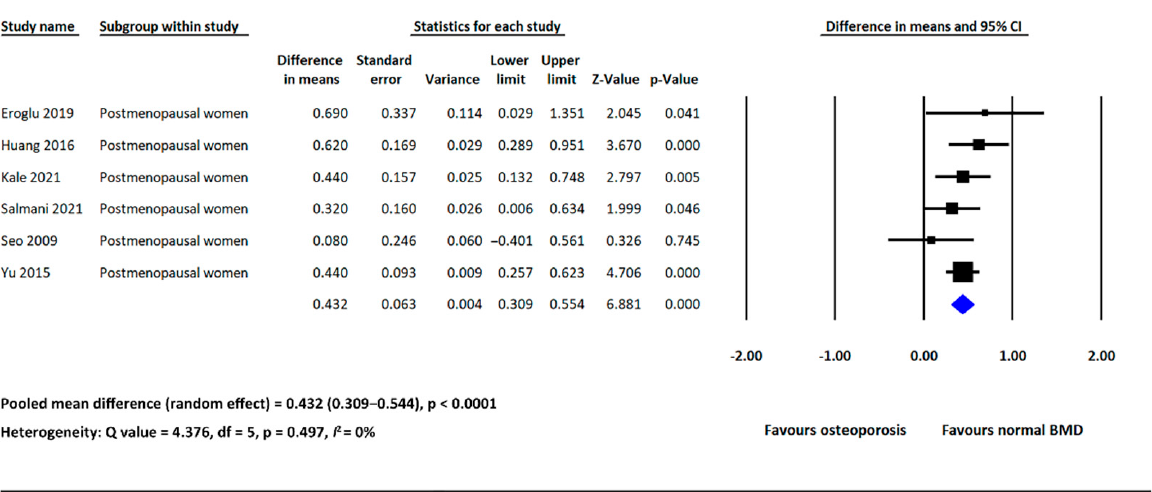
Figure 3. Forest plot of the mean difference in NLR between the osteoporosis and normal BMD groups in postmenopausal women [17,18,20,21,25,26].